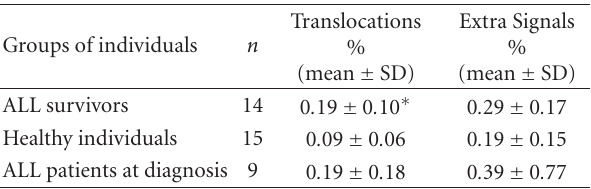
Table 4: Mean frequency of IGH/CCND1 translocations and extra signals obtained for ALL survivors, healthy individuals, and patients at the time of initial diagnosis.